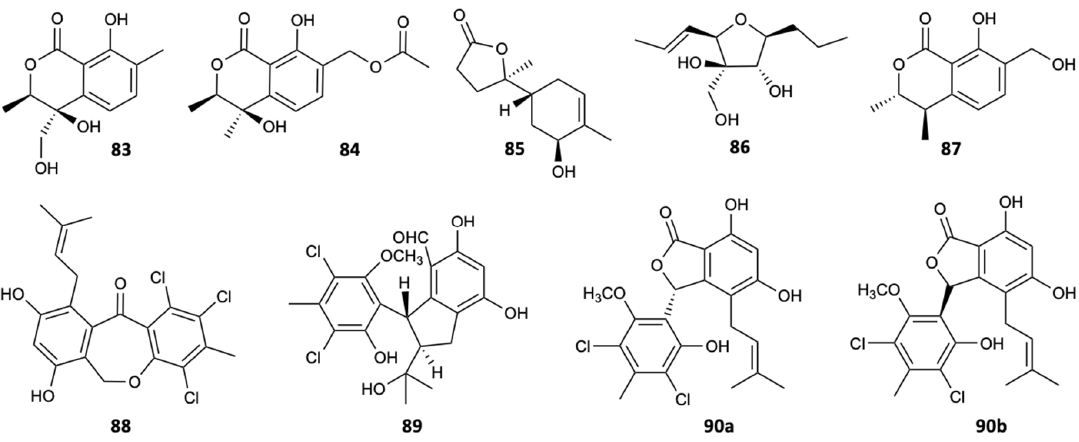
Figure 22. Structures of compounds 83 – 90a / 90b .